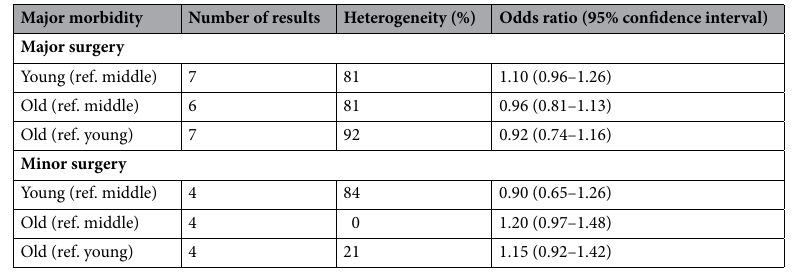
Table 2. Subgroup analysis of major morbidity stratified by major and minor surgery.